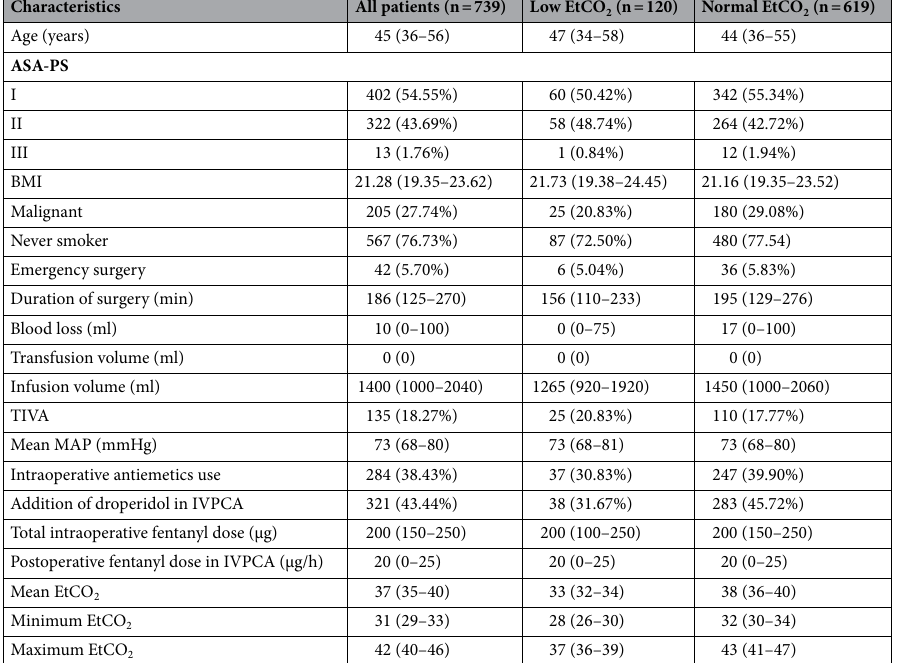
Table 1. Patient characteristics (n = 739). Values are given as median (interquartile range) or count (%). ASAPS American Society of Anesthesiologists Physical Status, BMI body mass index, TIVA total intravenous anesthesia, MAP mean arterial pressure, IVPCA intravenous patient-controlled analgesia, EtCO 2 end-tidal carbon dioxide.